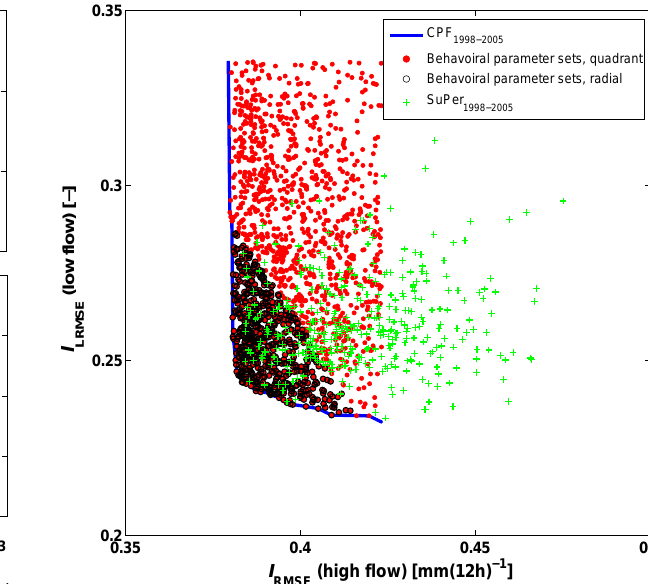
Fig. 7. CPF 1998 − 2005 is shown by the blue line. Black circles and red dots illustrate the parameter set retained by radial and quadrant rules (see Sect. 3.3, Fig. 3). The green crosses indicate the perfor- mance of parameter sets identified by MDPF 1998 − 2005 over the pe- riod of